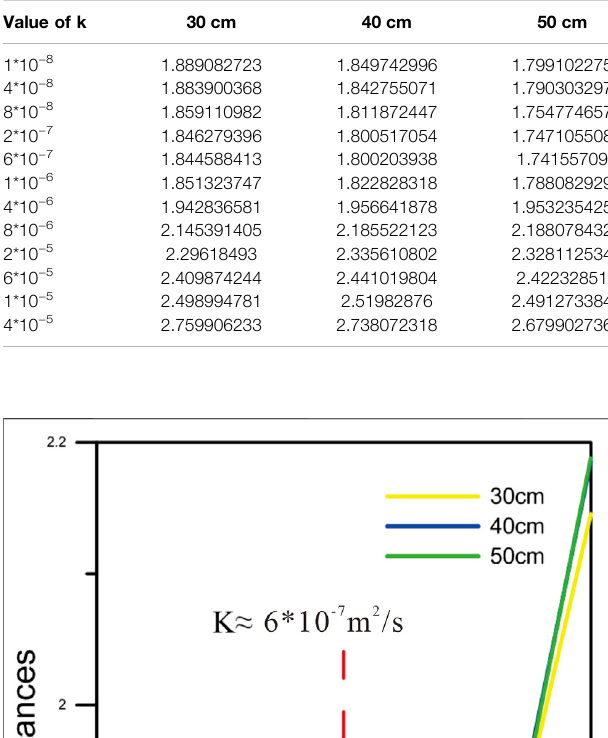
Frontiers in Earth Science |